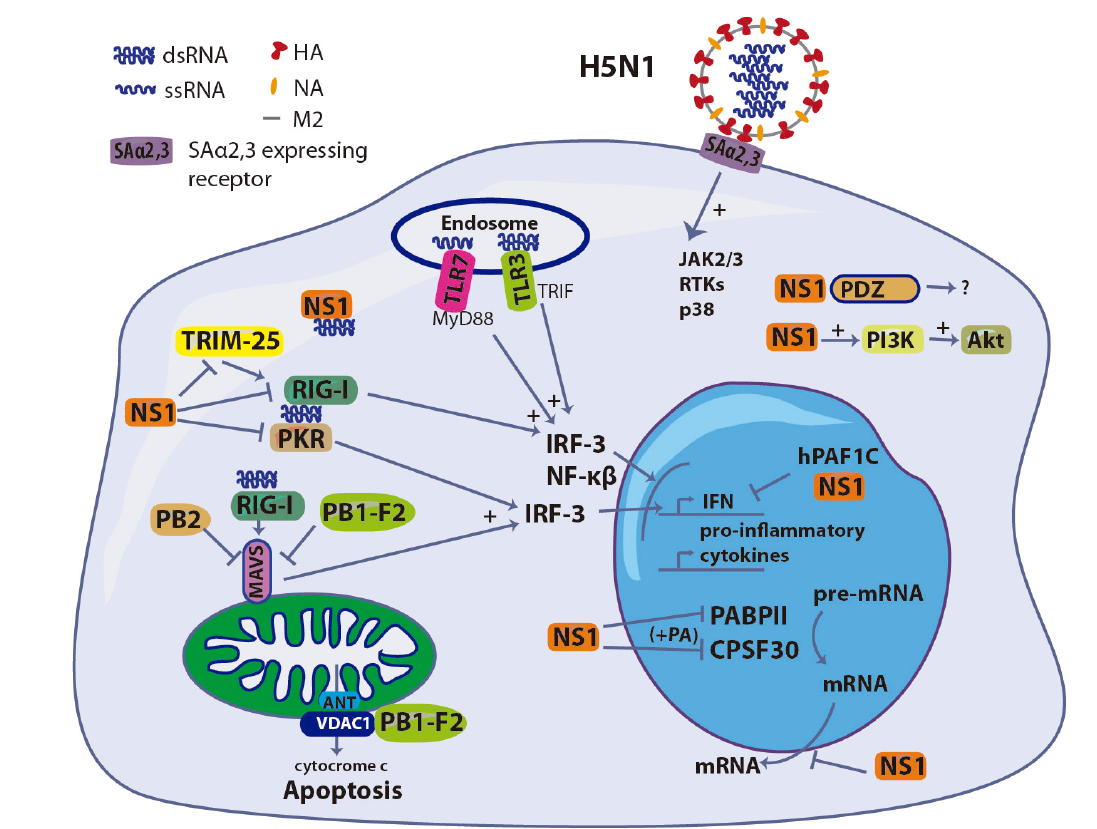
Figure 2. Induction and antagonist role of different components of H5N1 IAV in the innate immune response in the host-cell. ssRNA, dsRNA and HA participate in the induction of the production of IFN and pro-inflammatory cytokines, while NS1, PB1-F2, PB2 and PA have an antagonist